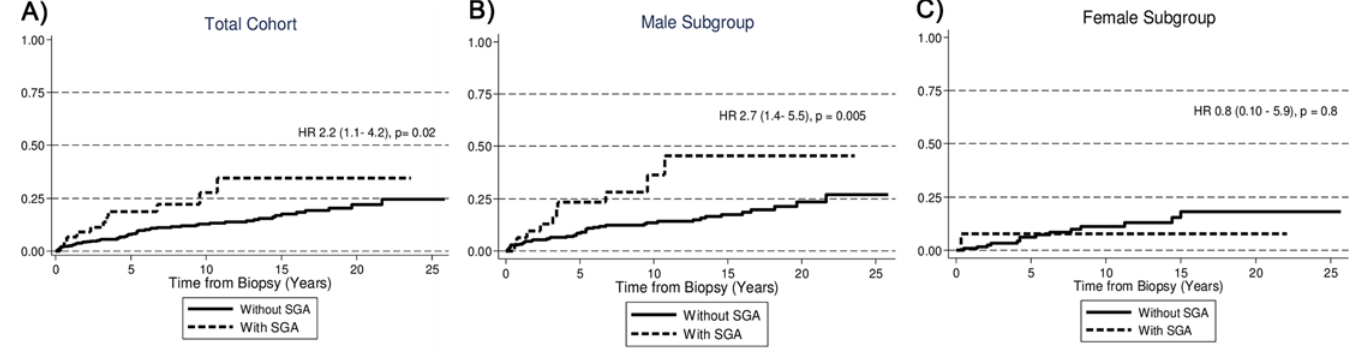
Fig 2. Cumulative Probability of ESRD in patients with IgAN according to whether or not the patient had SGA.